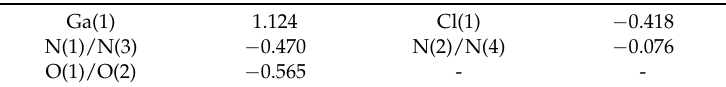
Table 2. Charge Distribution of the (pyNO − ) 2 GaCl Complex.